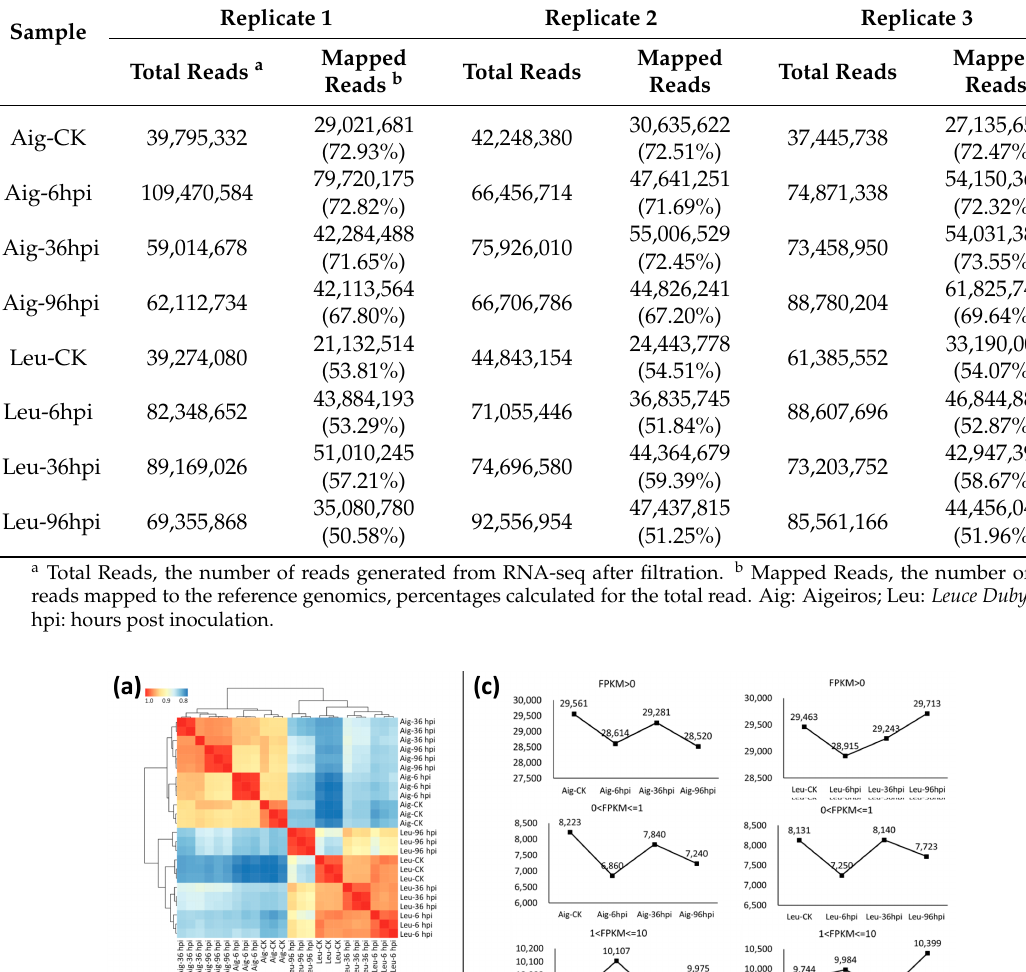
Table 1. Statistics of reads mapped onto the poplar reference genomes.